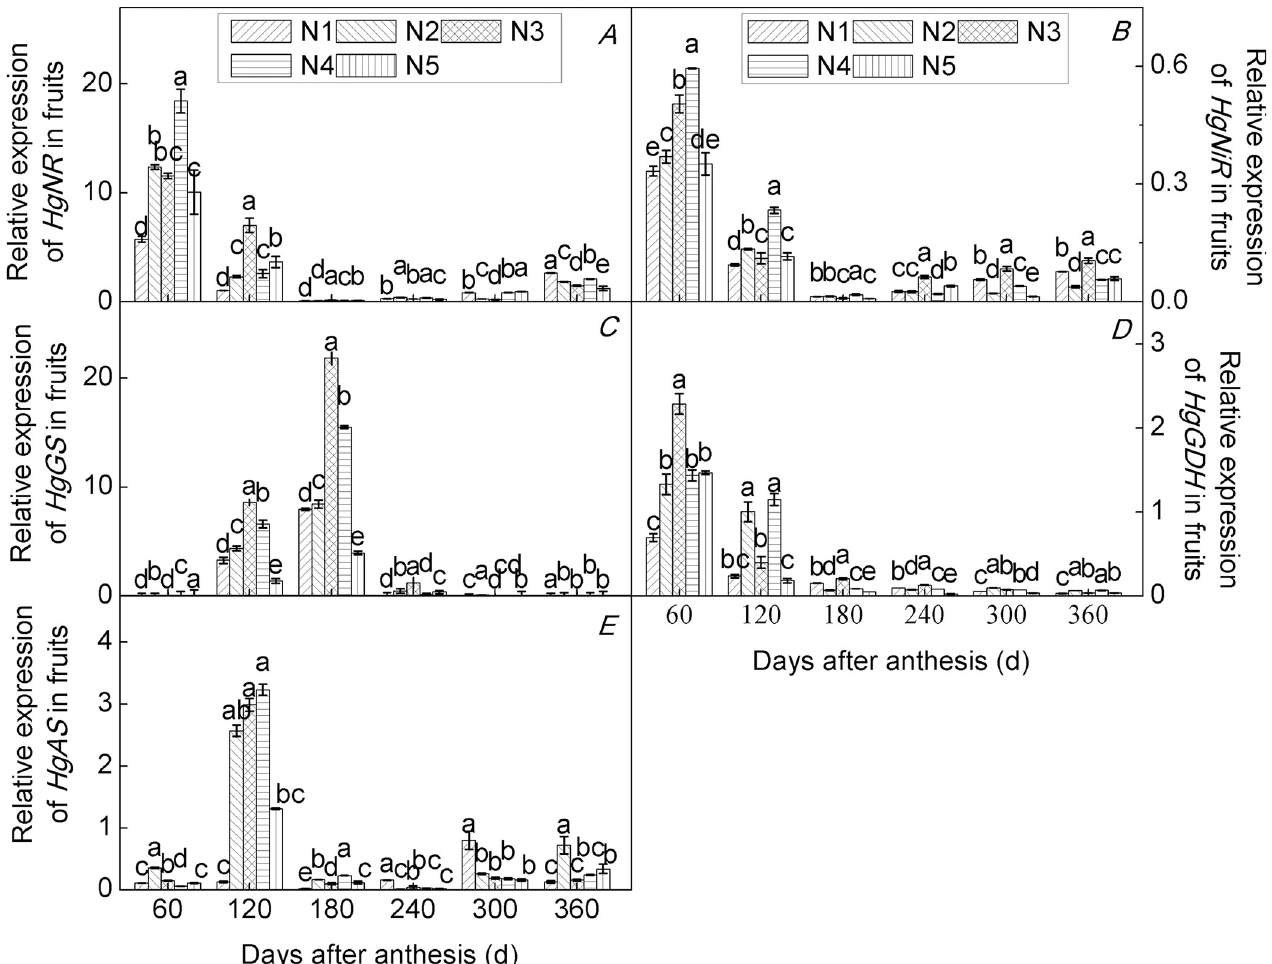
Fig 5. Relative gene expression in fruits of the citrus cultivar ‘Huangguogan’. HgNR (nitrate reductase, A), HgNiR (nitrite reductase, B), HgGS (glutamine synthetase, C), HgGDH (glutamate dehydrogenase, D) and HgAS (asparagine synthetase, E) N 1 : 0, N 2 : 1.36, N 3 : 1.81, N 4 : 2.26, N 5 : 2.72 kg/year of N fertilizer [CO(NH 2 ) 2 , N �